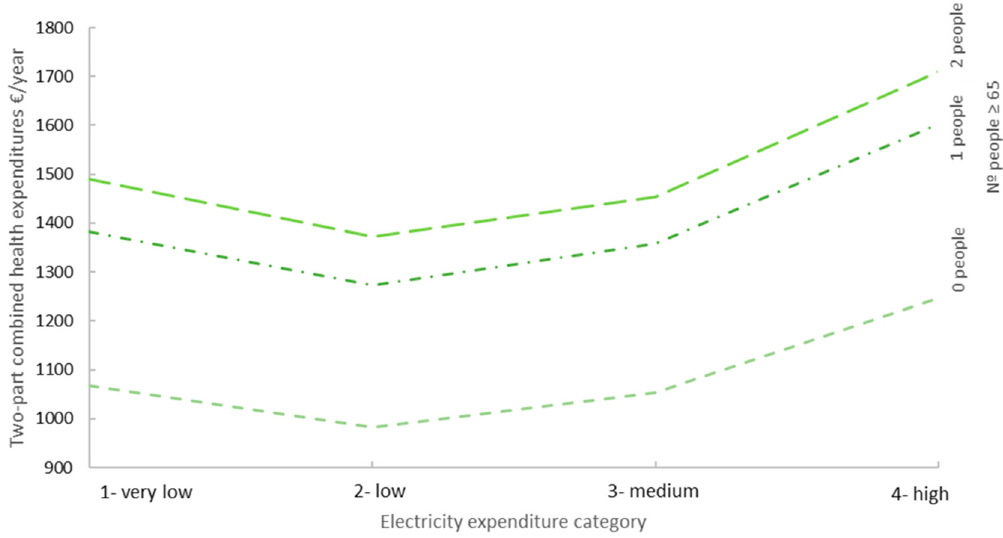
Figure 5. AAP for health expenditures by electricity expenditure and n° people above 65.